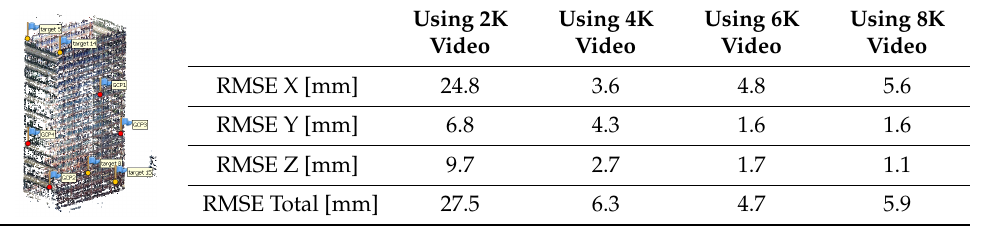
Table 3. RMSE estimated at the checkpoints distributed over the building facades at the four drone video resolutions.